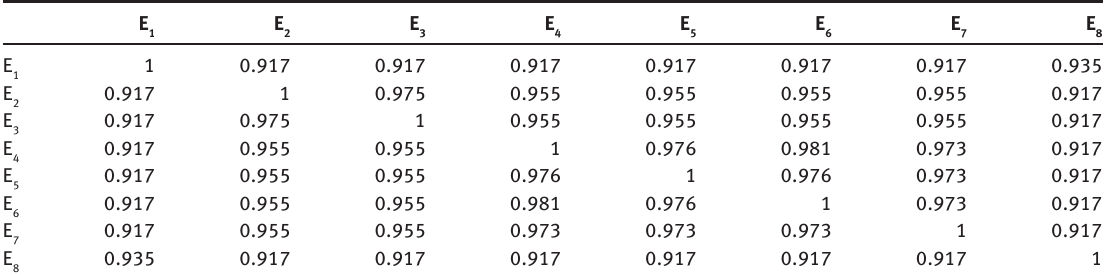
Table 2: Classification of Experts: Fuzzy Equivalence Relation Obtained Using the Cosine Amplitude Method (Eight Experts, 226 Patients).